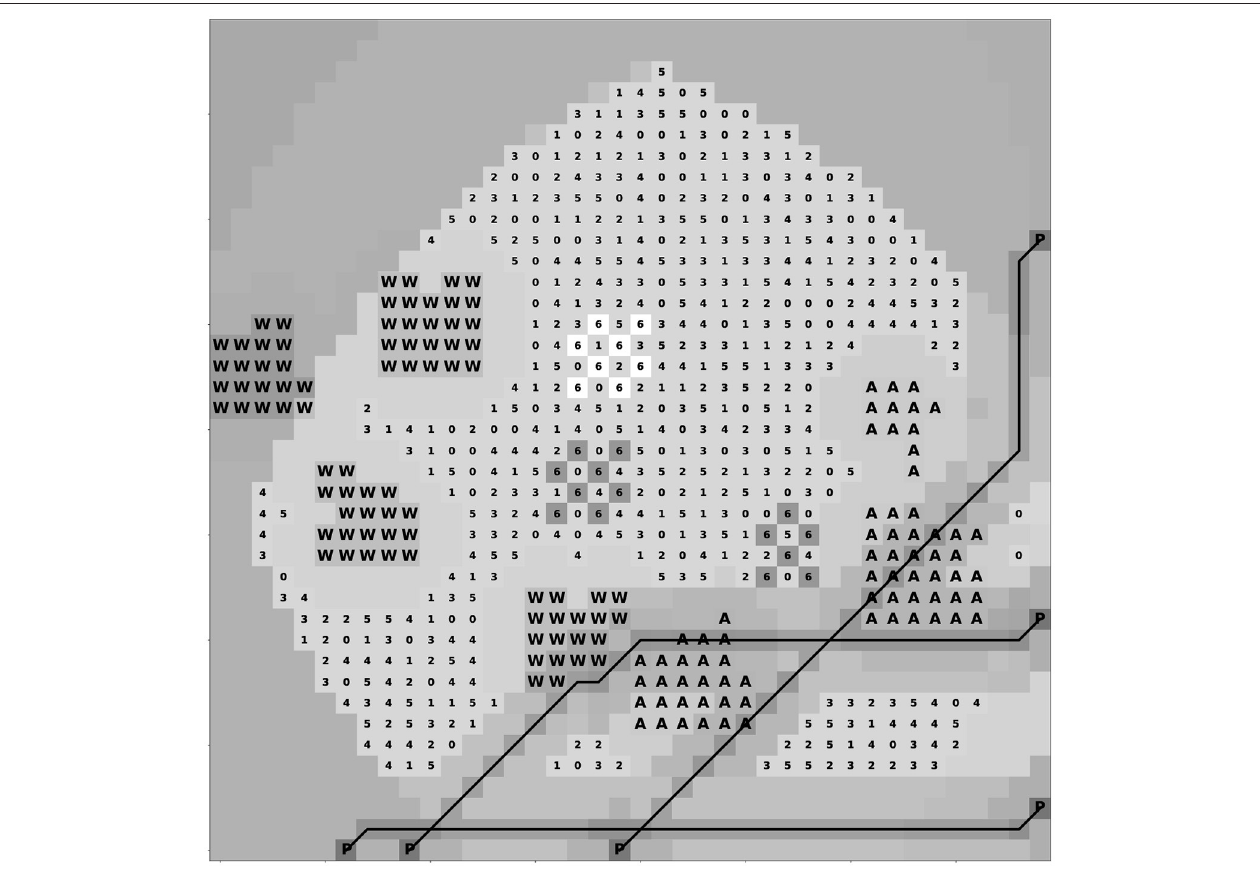
FIGURE 9 | The sample validity map with multiple non-compact areas.